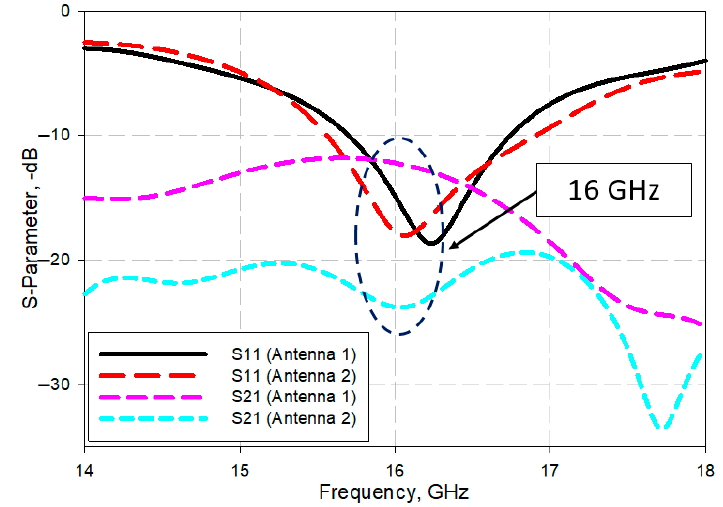
Figure 6. Comparison of S-parameters for Antenna 1 and Antenna 2.